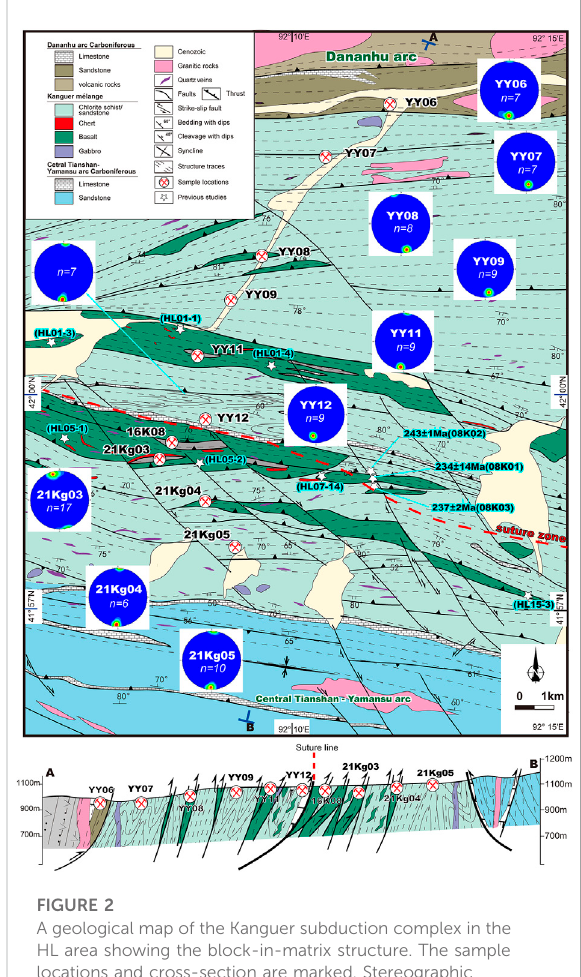
FIGURE 2 A geological map of the Kanguer subduction complex in the HL area showing the block-in-matrix structure. The sample locations and cross-section are marked. Stereographic projections of cleavages in the mélange matrix along the